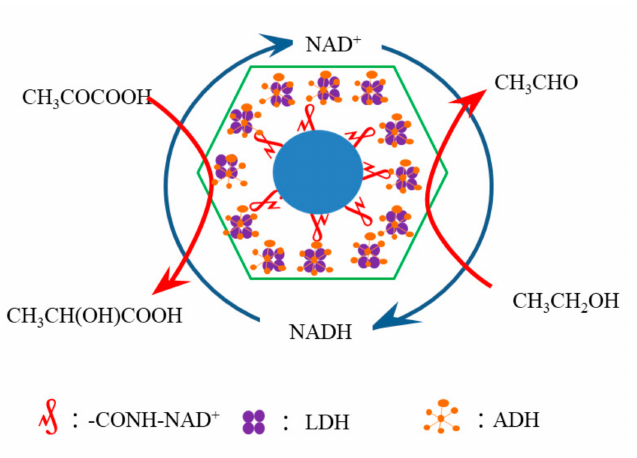
Figure 4. Flow chart of the reaction about the ZIF@ADH/NAD-MSN/LDH. ADH: Alcohol dehydro- genase; LDH: Lactate dehydrogenase; NAD + : Nicotinamide adenine dinucleotide; ZIF@ADH/NAD- MSN/LDH: Core–shell nanocomposites prepared by ZIF-8 immobilized ADH, LDH, and